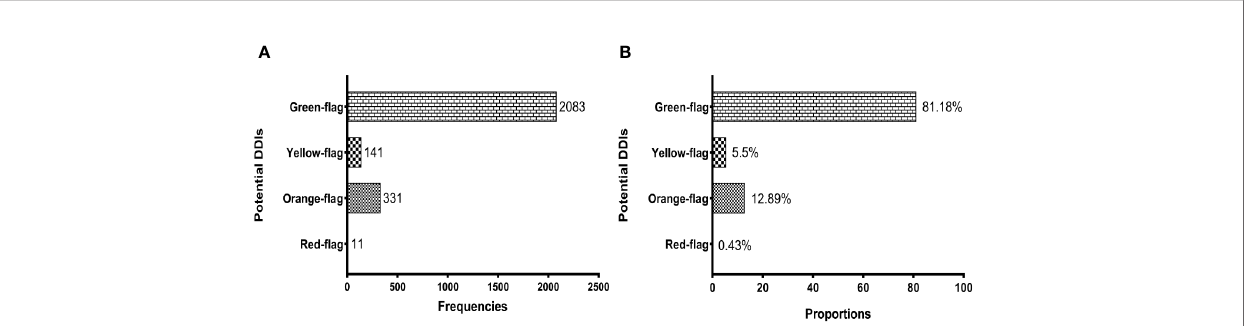
FIGURE 1 | Potential drug-drug interactions (DDIs) among people living with HIV. (A) shows the prevalence of DDIs according to frequencies and (B) re fl ects their prevalence based on proportions. Potential DDIs between antiretroviral and non-antiretroviral drugs are represented with different shades according to the severity of potential DDIs: Red- fl ag (contraindicated), Orange- fl ag (potential clinical relevance requiring dosage adjustment or close clinical monitoring), Yellow- fl ag (weak clinical signi fi cance), and Green- fl ag (no interaction).